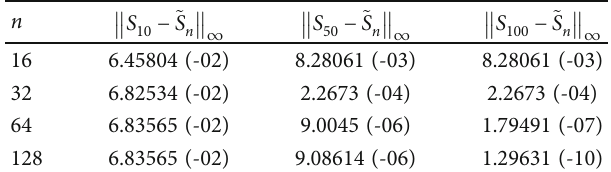
Table 7: Error norms between S ~ S n